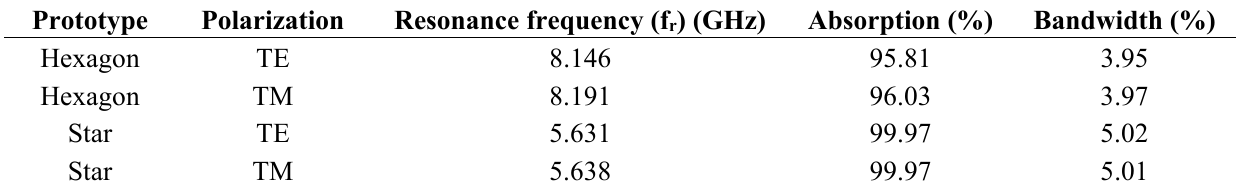
Table 1. Comparative results between hexagonal and star designs.